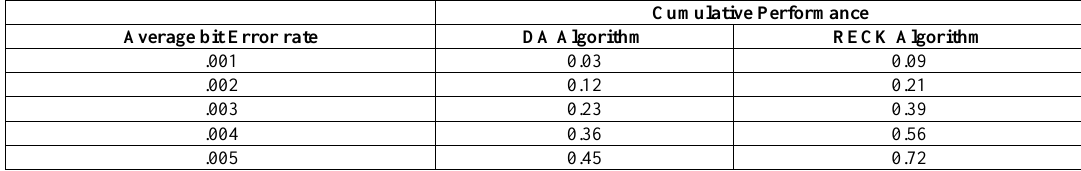
Table 4. Highlights the data of DA and RECK algorithm on the basis of average bit error